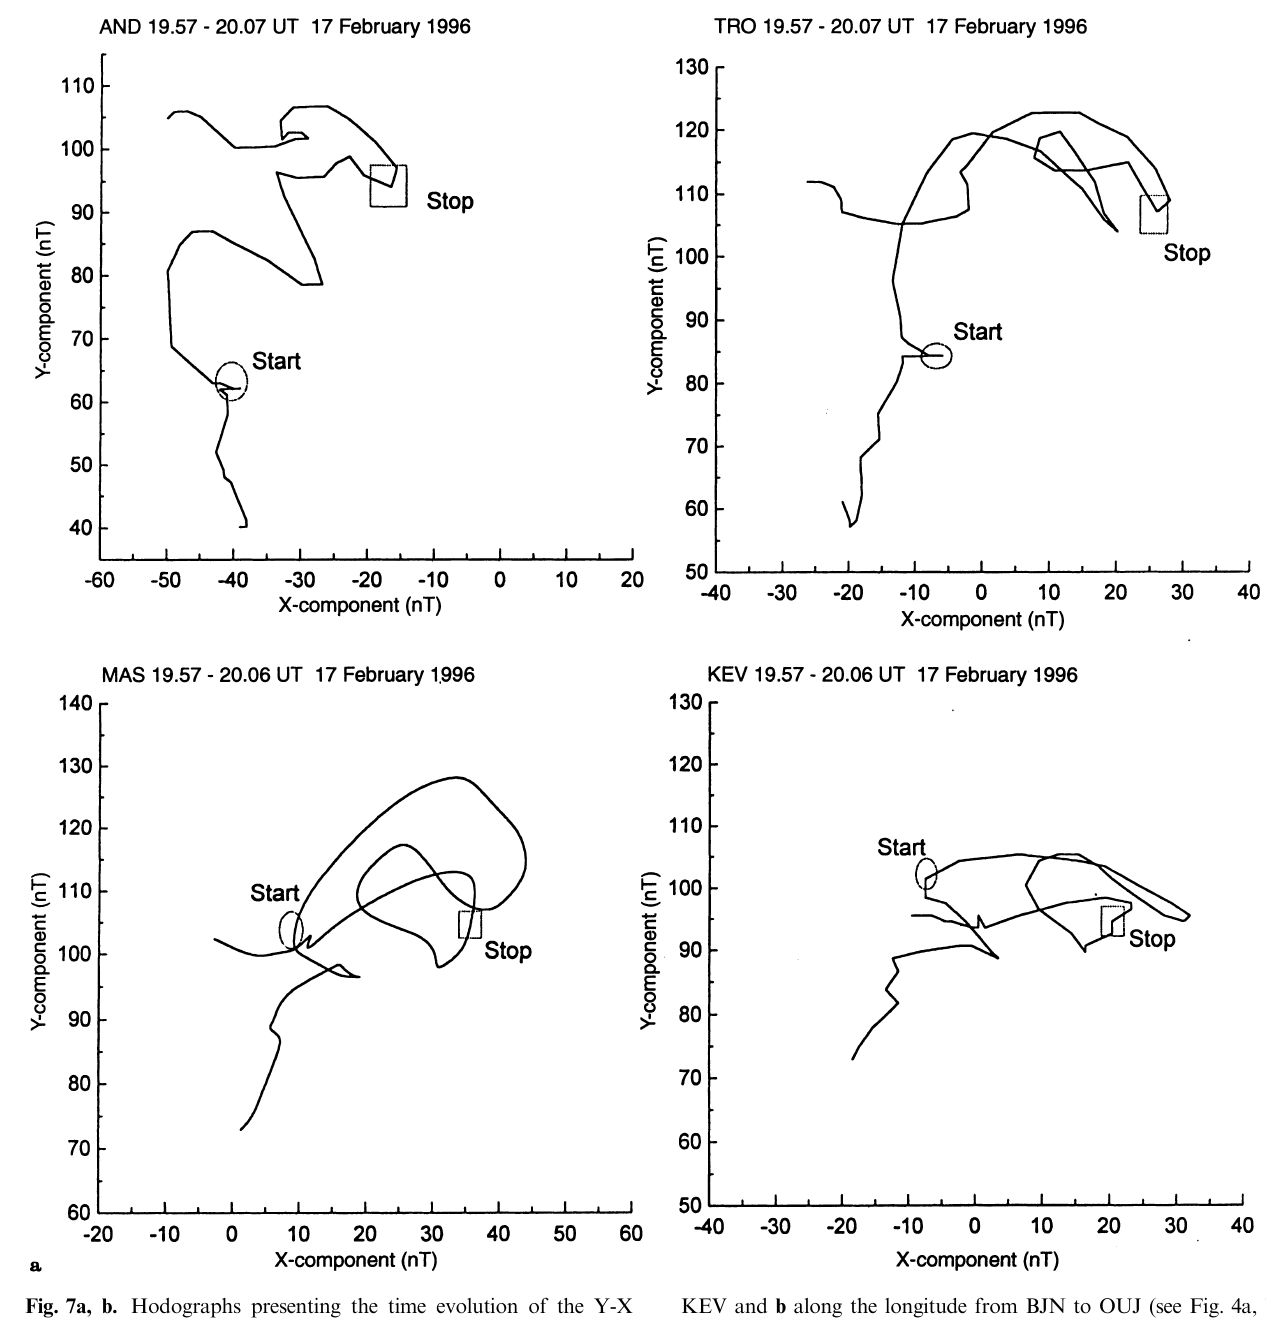
Fig. 7a, b. Hodographs presenting the time evolution of the Y-X polarization surfaces on 17 February, 1996 for the time interval from 19.57 to 20.06 UT containing the first heating cycle (from 20.00–20.04 UT) from IMAGE magnetometers, a along the latitude from AND to